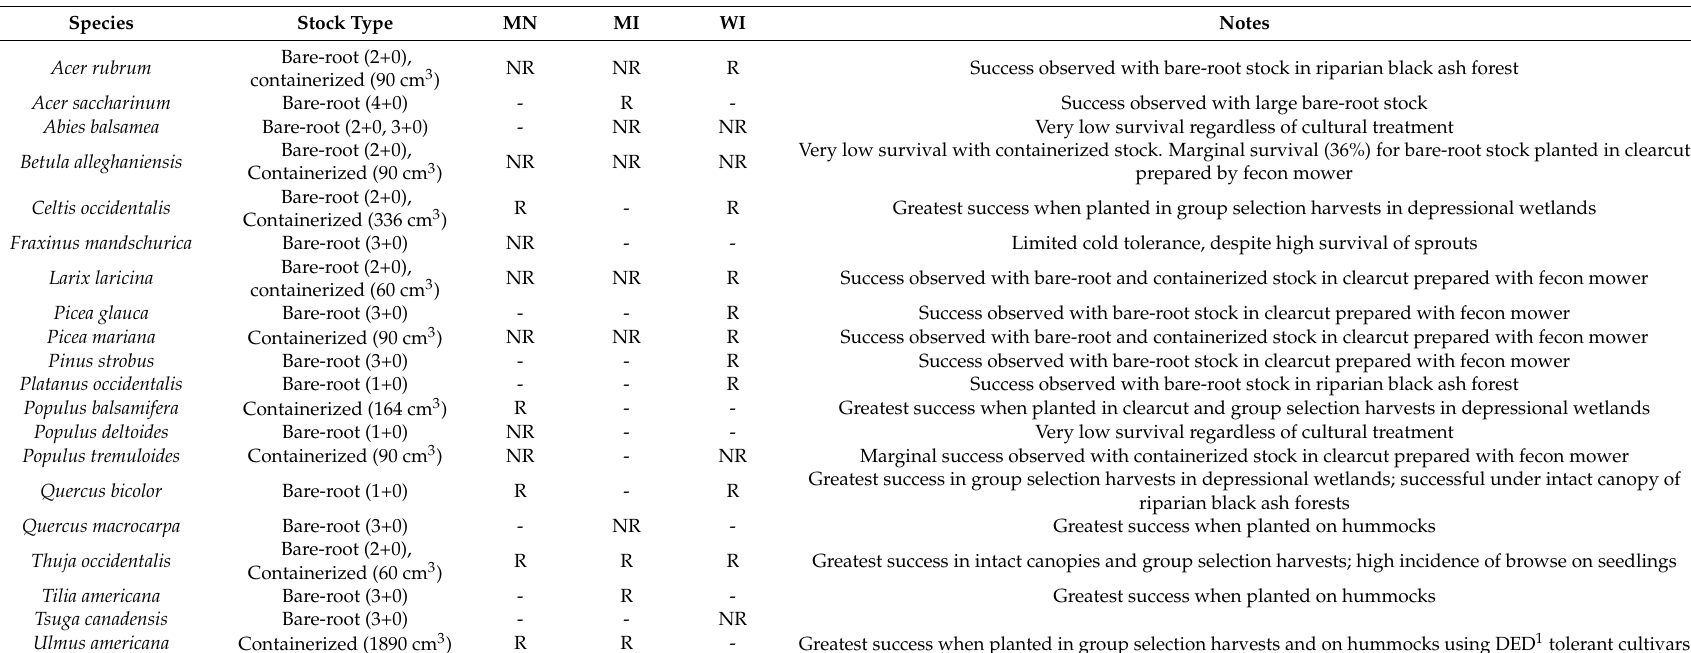
Table 1. Species planted as part of adaptive strategies for minimizing the impacts on emerald ash borer on black ash wetlands. General recommendation for